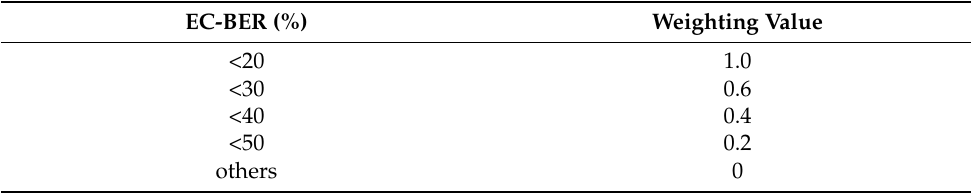
Table 1. Weighting value according to